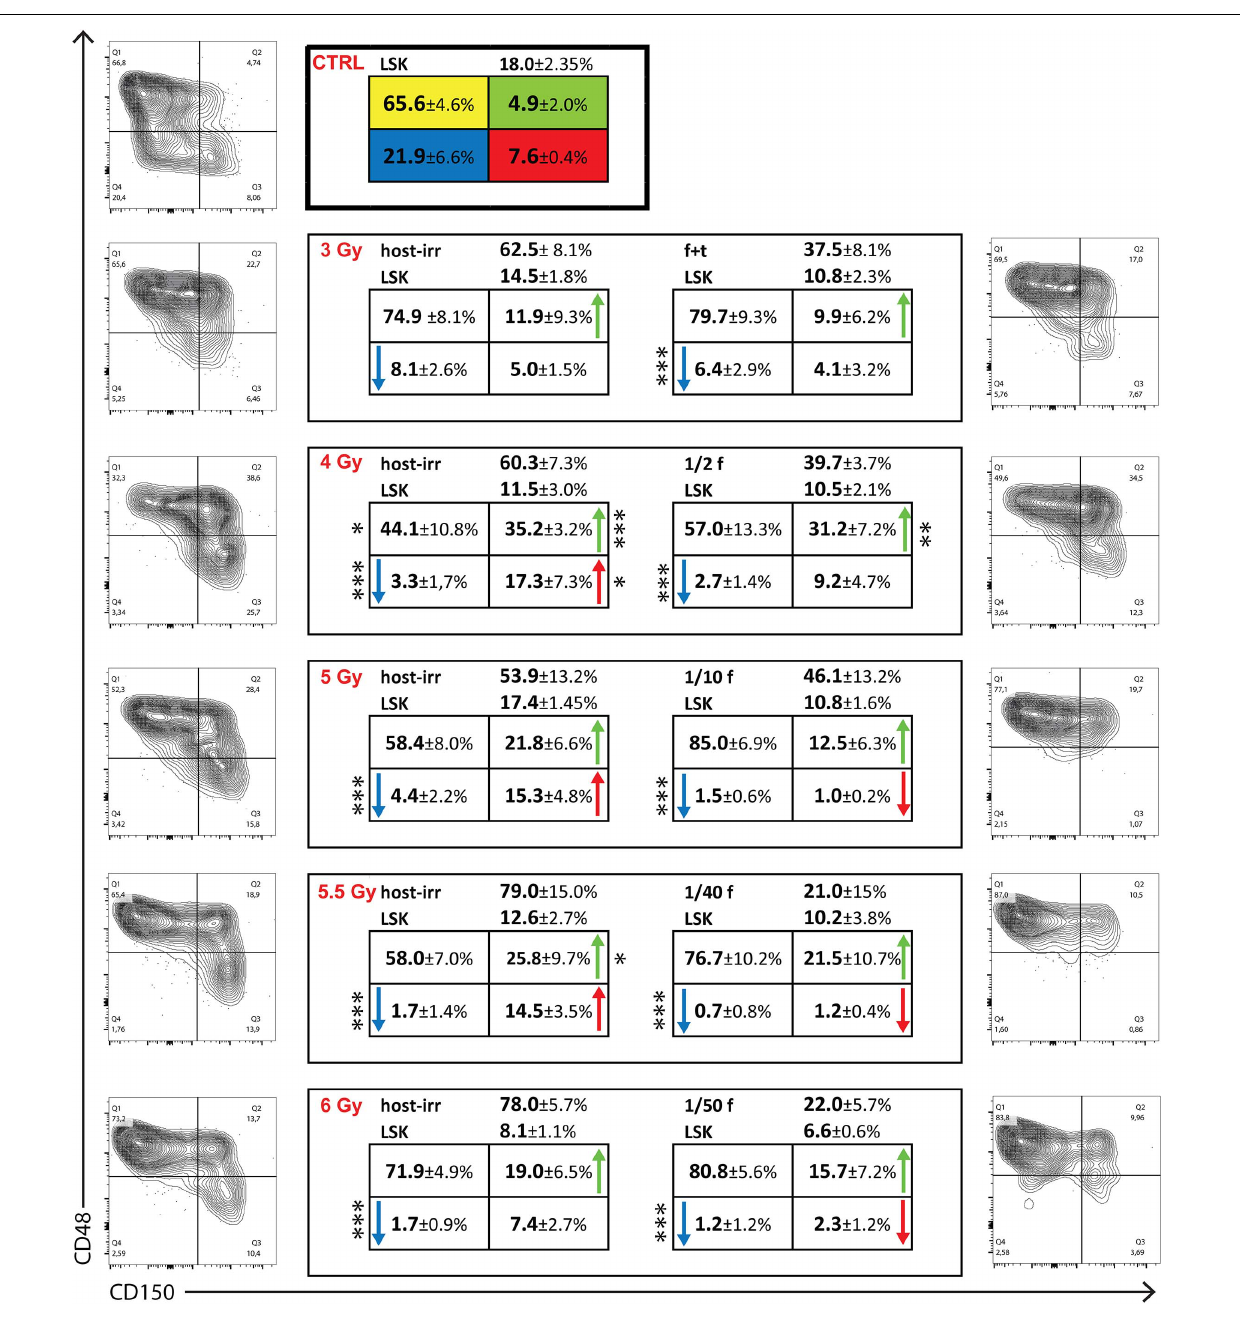
FIGURE 7 | LK cells in chimeric bone marrow reconstituted from transplanted and endogenous cells 1 month after transplantation. Groups of 3 CD45.2 male mice were irradiated at 3, 4, 5, 5.5, or 6 Gy and transplanted with bone marrow of CD45.1 male mice in an amount equivalent to that in femur and tibia, 1/2 femur, 1/10 femur, 1/40 femur, and 1/50 femur. Bone marrow was collected after 1 month, stained for CD45.2, CD45.1, differentiation lineages, c-Kit, Sca-1, CD150, and CD48 markers. The percentage of CD45.2 (host-irr) and CD45.1 (transpl) is shown in LK cells and the percentage of Sca-1-positive (LSK) cells. LSK cells are divided into four CD150/CD48 subtypes, and the percentage of each is shown as mean ± SD. Representative CD150/CD48 plots of LSK cells are shown. CTRL is for three untreated mice (CD45.2); host-irr is for the hematopoiesis derived from endogenous cells in submyeloablatively irradiated (CD45.2) mice; tanspl is for the hematopoiesis derived from transplanted (CD45.1) bone marrow cells. * p < 0.05, *** p <